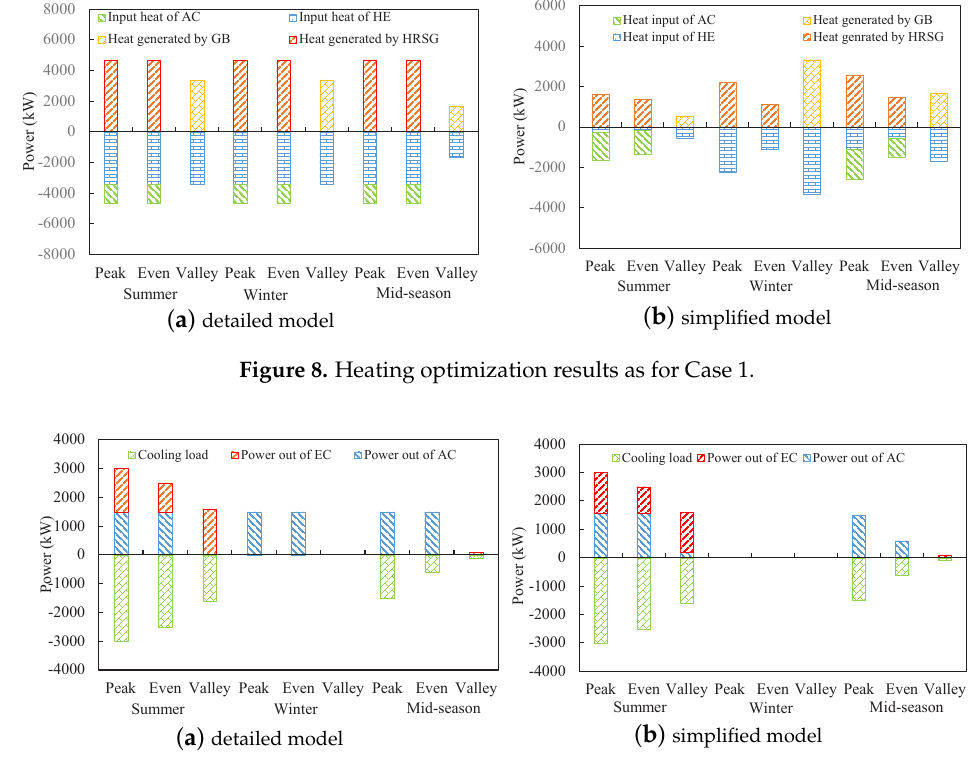
Figure 9. Cooling optimization results as for Case